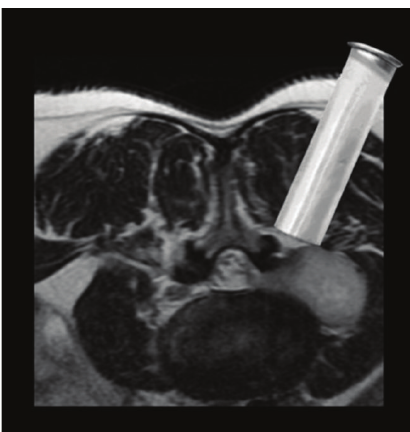
Figure 2: Resection of a completely extradural lumbar schwannoma through a minimally invasive approach using an expandable trans- muscular tubular retractor, positioned laterally to the facet joint complex.